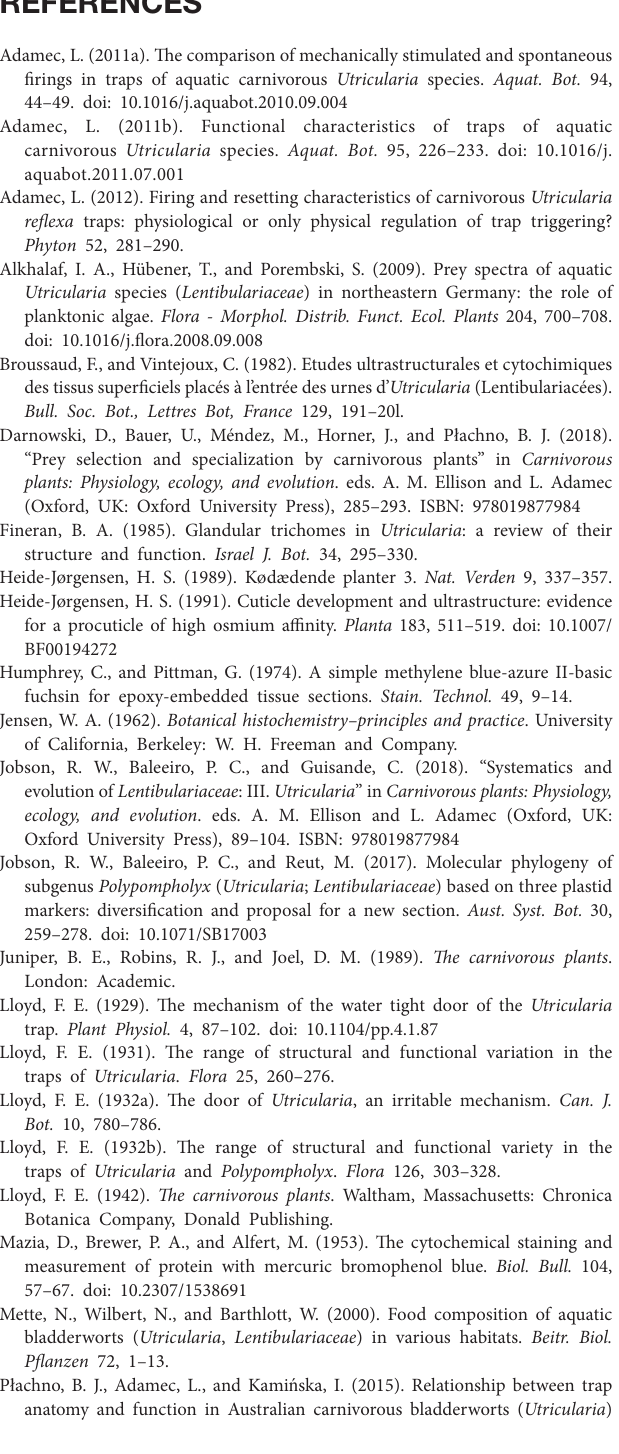
trap opening is guarded by the outer velum (red ellipse). (D) Utricularia novae - zelandiae , view of a trap entrance showing the ring of the velum (red circle); scale bar = 200 μm. (E) Transverse selection of the threshold showing velum (red ellipse) of Utricularia vulgaris trap type. (F) Utricularia reflexa, a semi-thin longitudinal section of the threshold showing velum (red ellipse); scale bar = 50